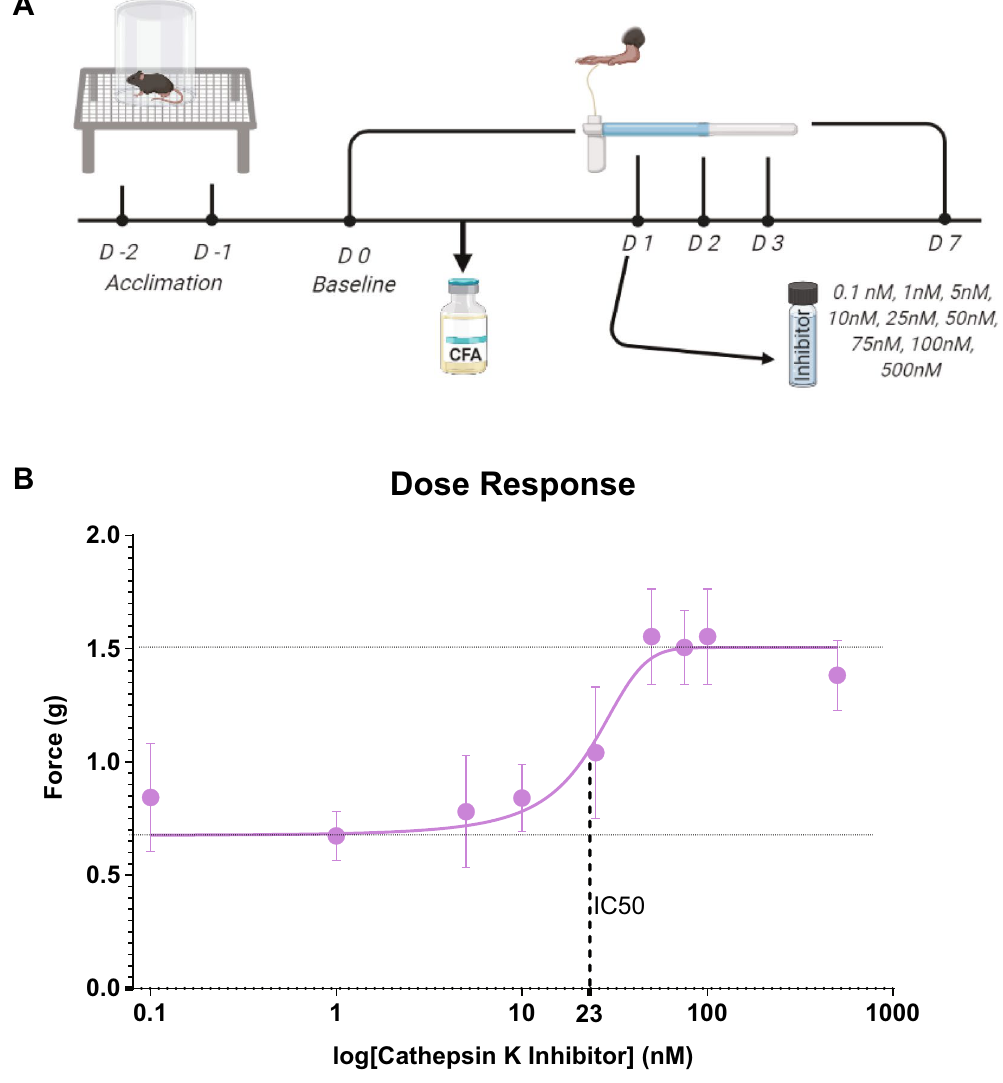
Figure 2. Dose–response curve of cathepsin K inhibitor in mice. ( A ) Timeline for the dose–response curve. Nine different concentrations of cathepsin K inhibitor were selected. Each group of WT mice was given an injection of one of the nine different concentrations of the cathepsin K inhibitor on day 1 post-CFA (complete Freund’s adjuvant) injection. Their response to each concentration of the inhibitor in terms of force (g) needed to induce paw withdrawal was recorded and these responses were used to plot a dose–response curve. ( B ) The calculated IC50 of the inhibitor is 23.26 nM, the top of the response curve lies at 1.51 g and the bottom of the response curve lies at 0.61 g. Of the doses tested, the inhibitor starts to show an effect at 5 nM and the effect peaks at 50 nM. Data are represented as mean ±